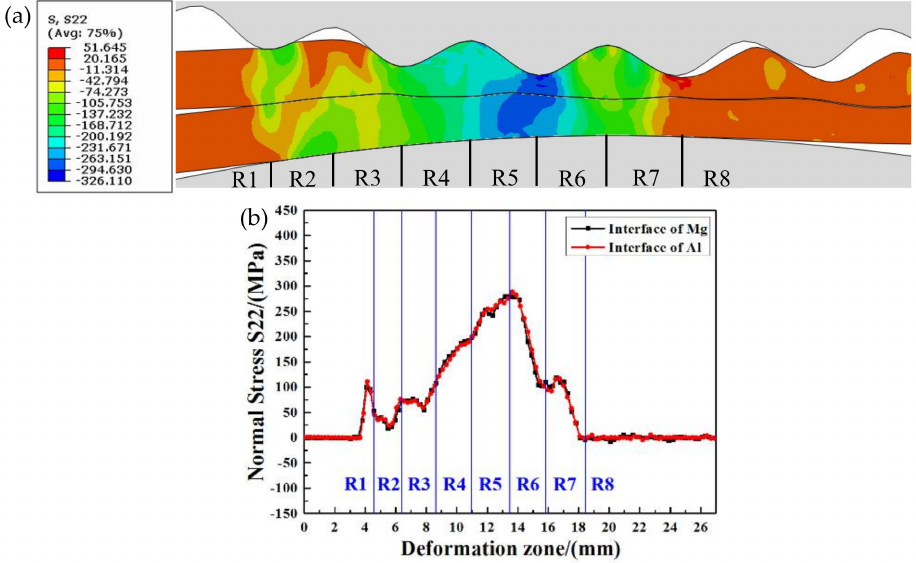
Figure 5. Normal stress distribution of interface metals in corrugated rolling deformation zone: ( a ) normal stress nephogram, ( b ) normal stress